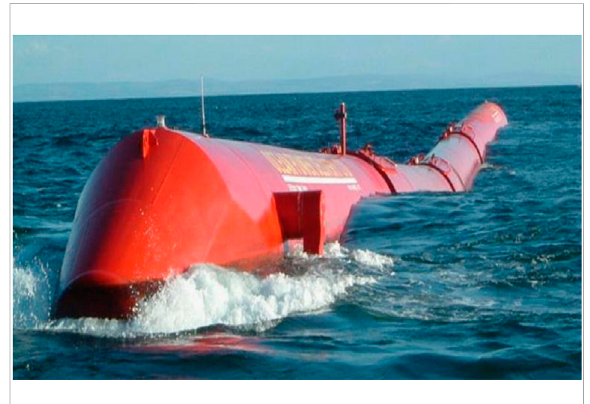
FIGURE 4 Pelamis wave energy conversion device (Yemm et al., 2012)